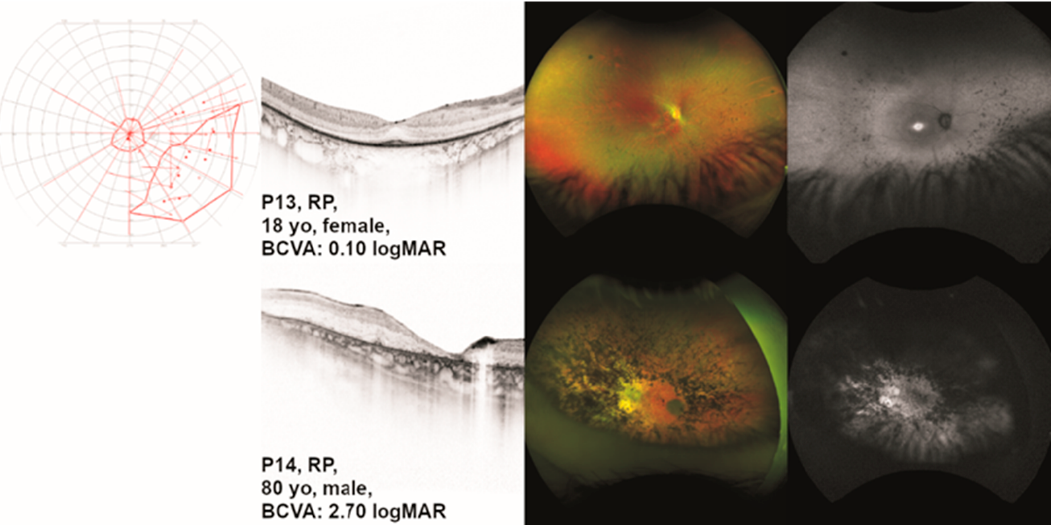
Figure 3. Clinical presentation of patients with TULP1 -associated retinitis pigmentosa (RP). One eye per patient is listed by age at examination from top to bottom including (where available) the results of kinetic visual field (VF) testing, optical coherence tomography (OCT), fundus photography, and fundus autofluorescence (FAF) imaging. Gender and best-corrected visual acuity (BCVA) are also